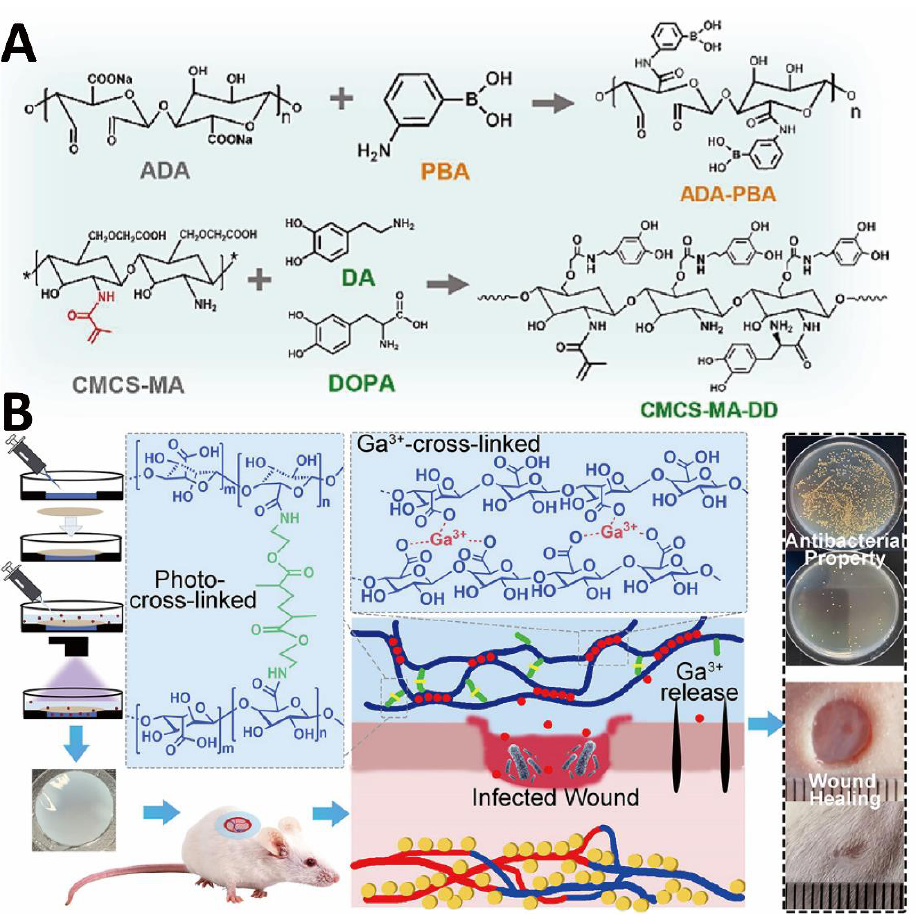
Figure 4. Alginate-based hydrogel bio-adhesives. ( A ) Preparation process of major components in H(P+T). Reprinted with permission from ref [96]. Copyright 2022 Elsevier. ( B ) Formation mechanism of double cross-linked alginate-based hydrogel bio-adhesive. It also demonstrated that the hydrogel bio-adhesive could effectively promote the healing of infected wounds. Reprinted with permission from ref [97]. Copyright 2022 American Chemical Society.